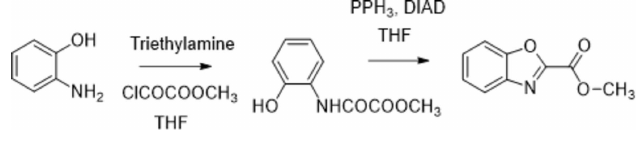
Figure 4 Synthesis route to methyl-1,3-benzoxazole-2-carboxylate.